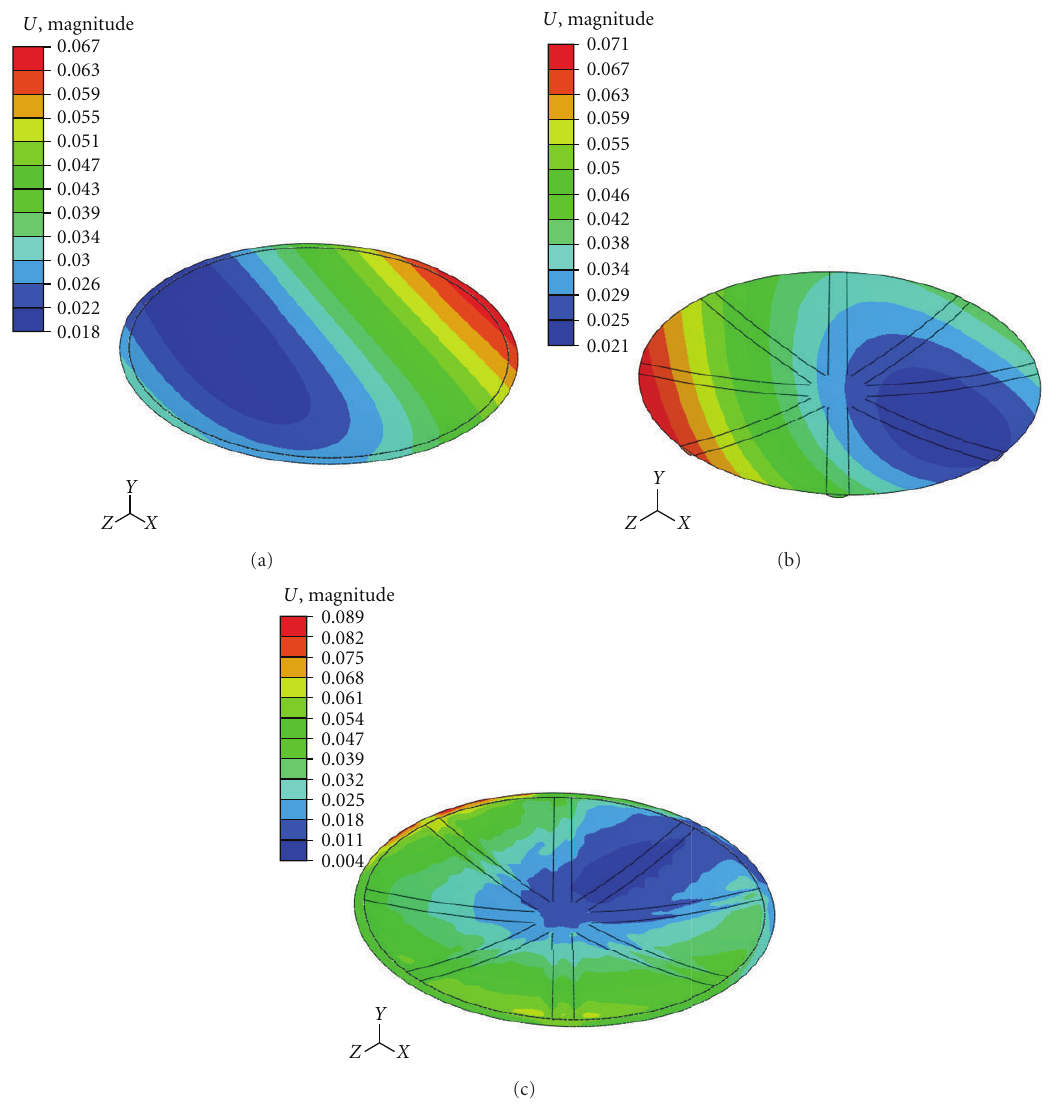
Figure 6: Displacement magnitudes due to LC3 thermal loading (units in mm), case E b (a), case D b , (b), and case ED b (c).